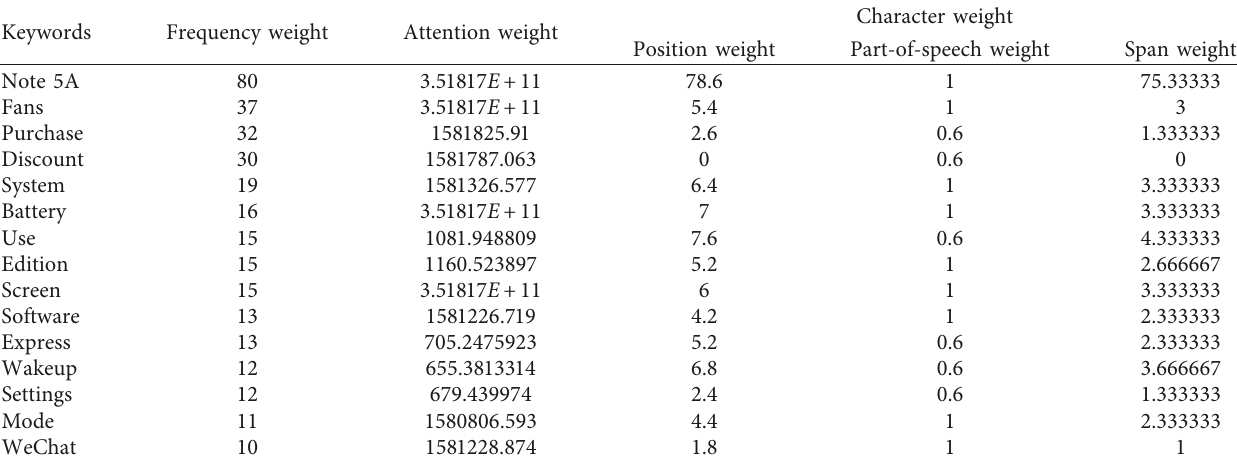
Figure 13: Visualized co-creation user network. Table 5: The extracted knowledge point keywords with top 15 frequency weight and their various